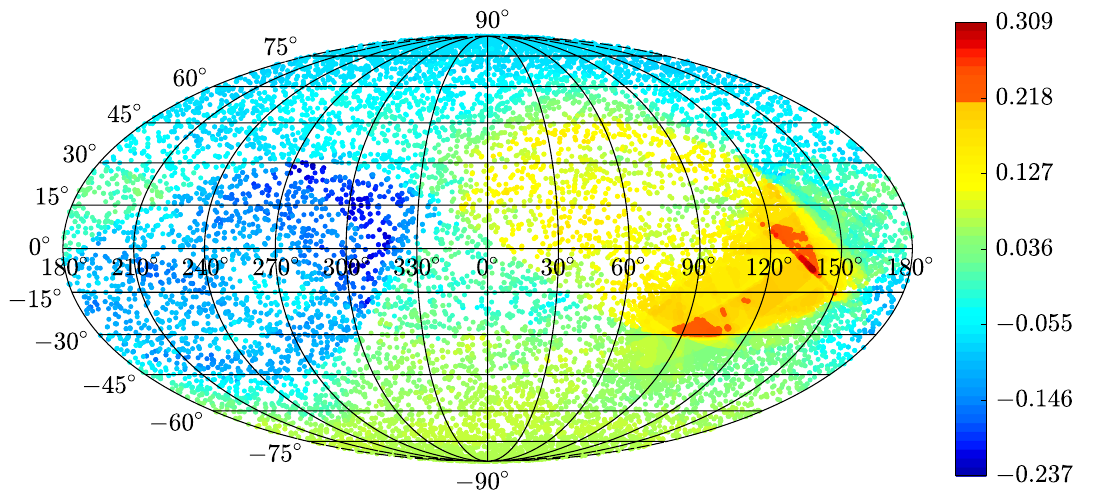
Fig. 2 The pseudo-color map of AL ( l , b ) in the galactic coordinate system, obtained by using the HC method to the Pantheon SNIa sample. The two “preferred directions” ( 138 . 08 ◦ , − 6 . 84 ◦ ) and ( 102 . 36 ◦ , − 28 . 58 ◦ ) are within the red regions. See the text for